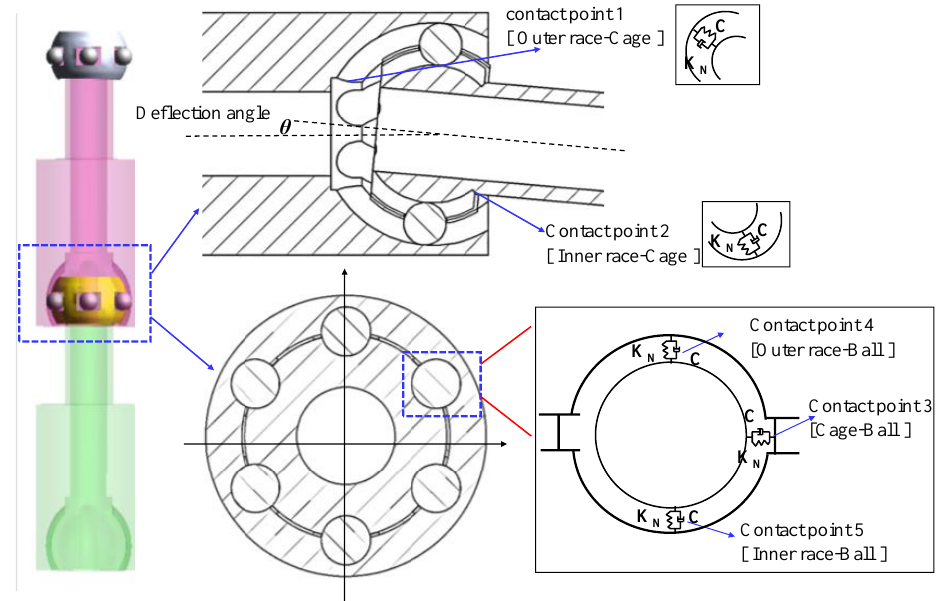
Figure 5. Position view of contact point on flexible joint (five points).